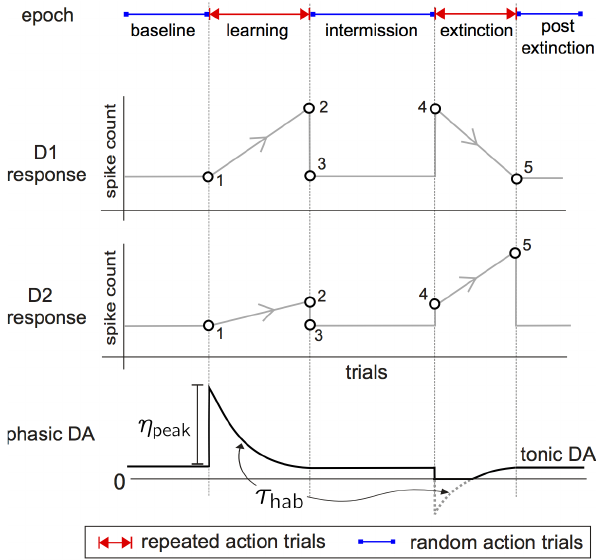
Figure 1. Stylised behavioural experiment for action discovery, with associated dynamics of MSN responses and phasic dopamine. The timeline at the top shows the experiment’s epochs. Below that we plot target response profiles of D1 and D2 type MSNs over each epoch of trials. These are based on the analysis in Figure 3 with the key points from that analysis shown by open symbols; grey lines between them show direction of change over the epoch. Stability is indicated by horizontal lines, and continuous (but not necessarily linear) plastic change is shown by lines with arrows between two open symbols. Bottom plot: trial-by-trial envelope-of-amplitudes of individual phasic dopamine events within each trial. This amplitude is governed by a variable g , whose value decays exponentially when describing positive dopamine signals (bursts) from some maximal value g peak . For negative going dopamine signals (dips) g rises exponentially over a trajectory that can be negative (dotted grey line). However, the phasic excursions of the level of dopamine itself, d , are always positive or zero, for when g v 0, d ~ 0 . The use of g in this way expediently fixes the interval over which d ~ 0 . In both cases the time constant of the dynamics of g is t hab .